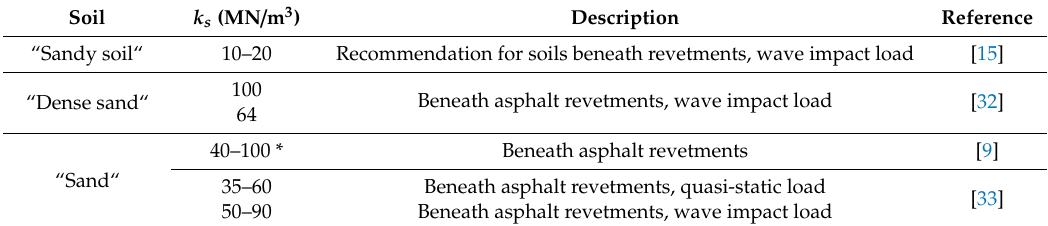
Table 5. Overview of moduli of subgrade reaction k s used for PEF revetment